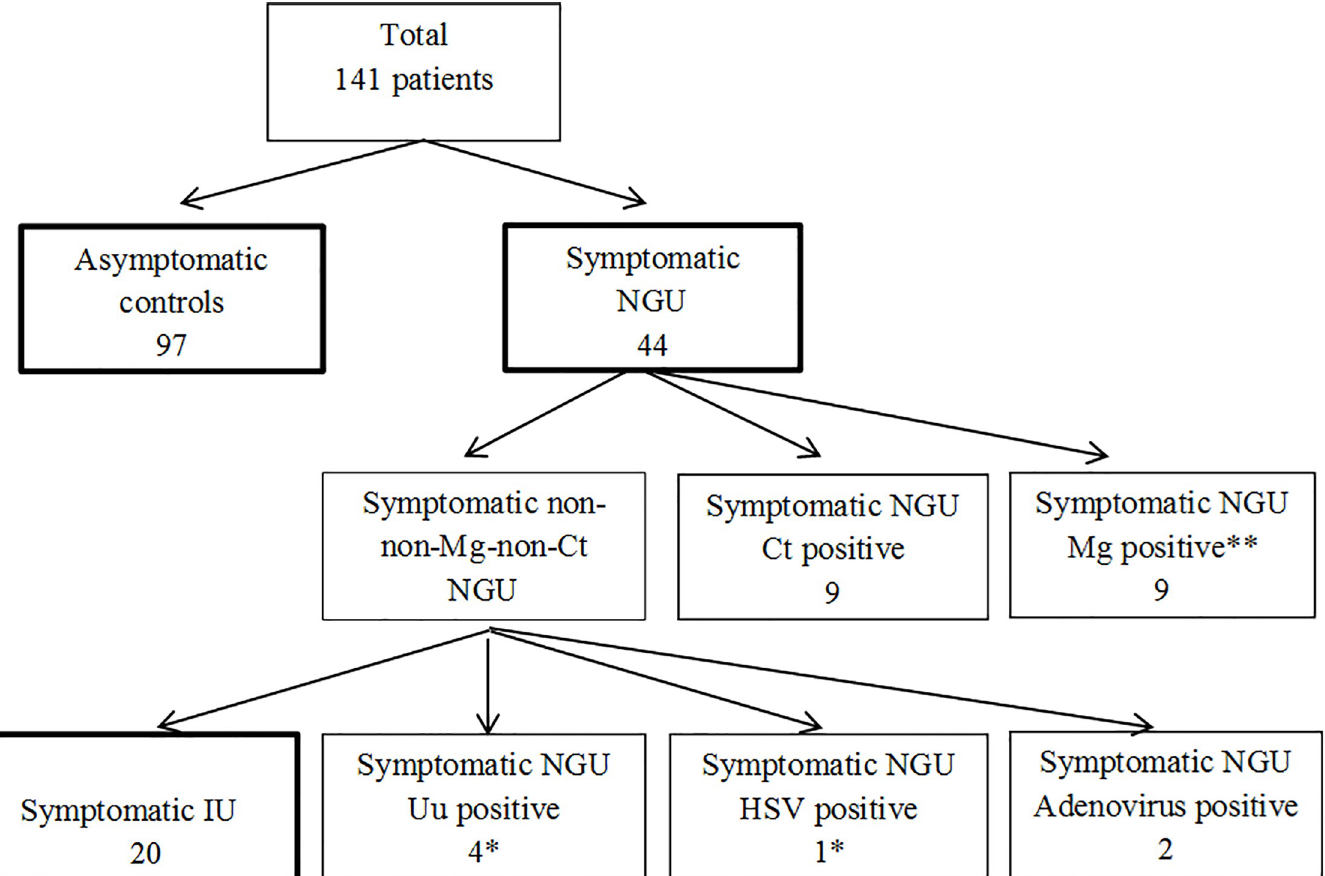
Fig 1. Flowchart showing included male patients (n = 141) and the different subgroups. C . trachomatis (Ct), M . genitalium (Mg), U . urealyticum (Uu), Idiopatic urethritis (IU). � 26 samples were U . urealyticum positive. †One sample was double-infected with HSV type 1 and M . genitalium . ‡ One sample was double-infected with HSV type 1 and U . urealyticum